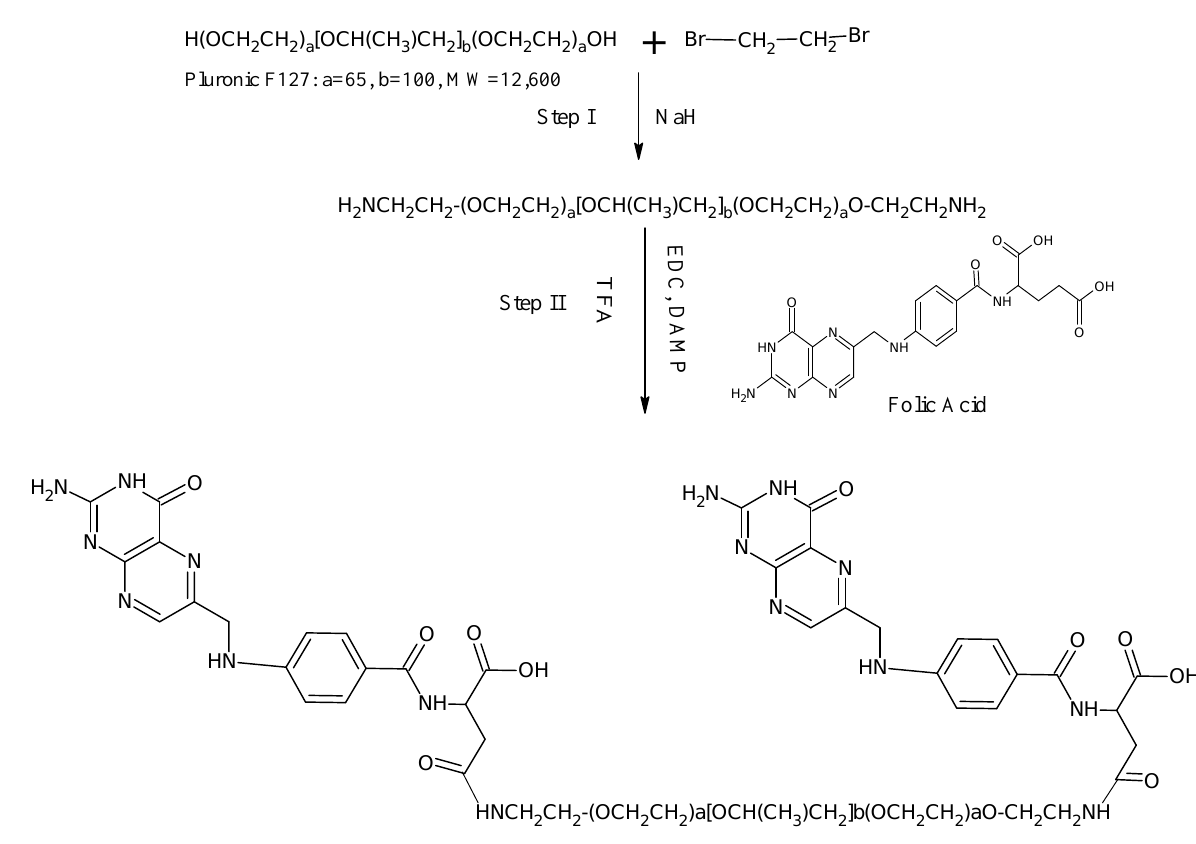
Figure 1. Schematic representation of conjugation of folic acid to Pluronic F127 nitrogen as the rea- gent.